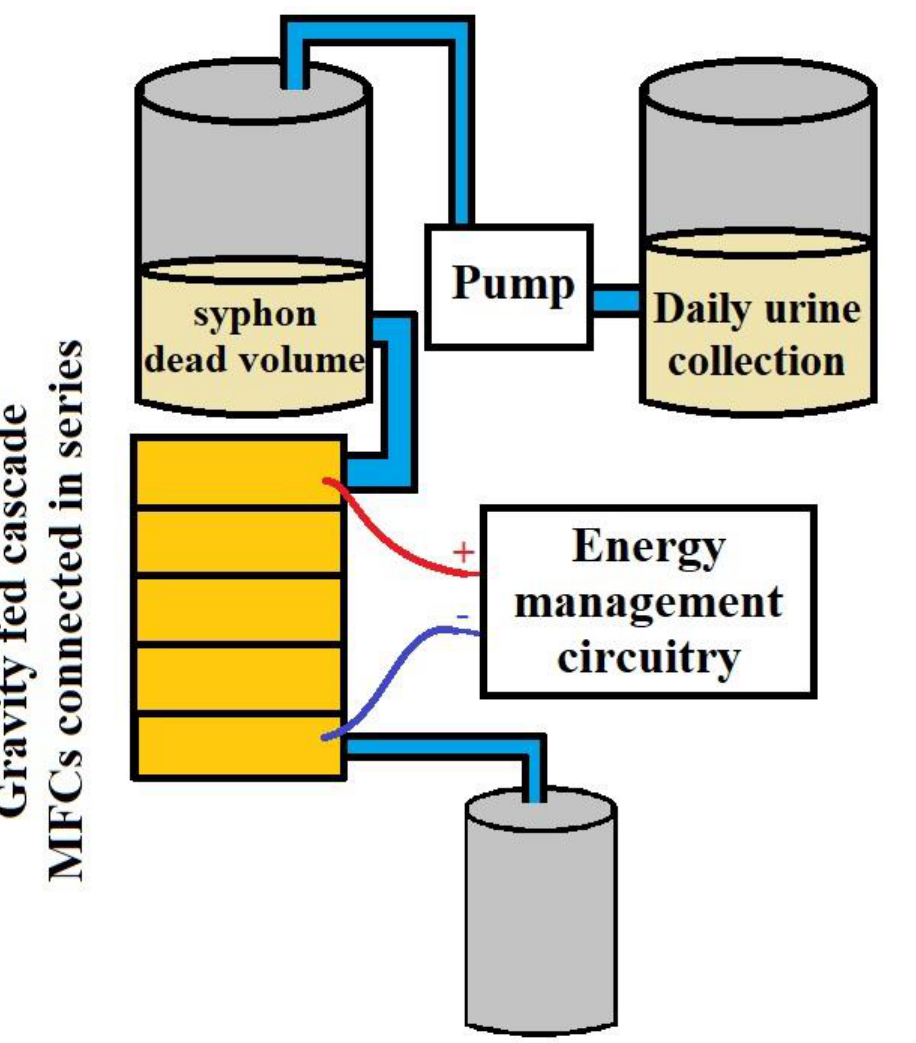
Figure 10. MFC arrangement of urine treatment and power generation (adapted from Walter et al. Walter et al. (2017) (2017) [83]).